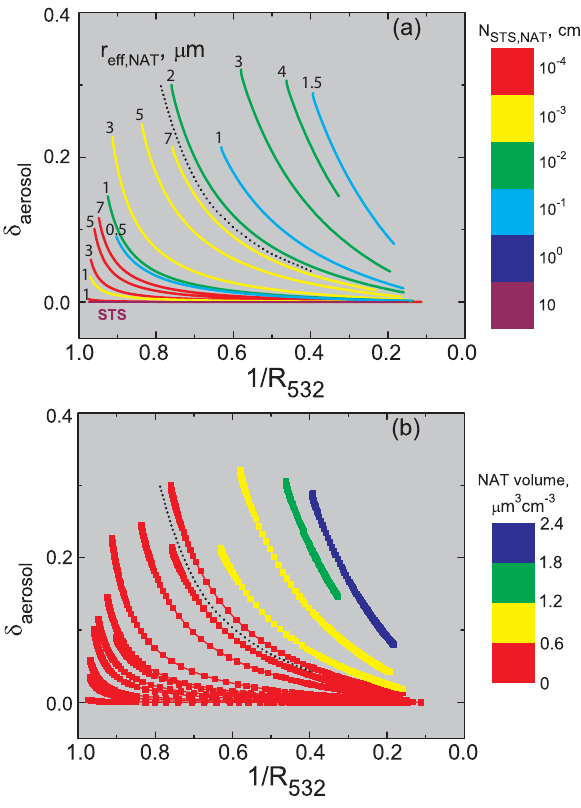
Fig. 5. Theoretical results for STS and STS-NAT mixtures. Color scale= (a) Particle number density; (b) NAT particle volume.